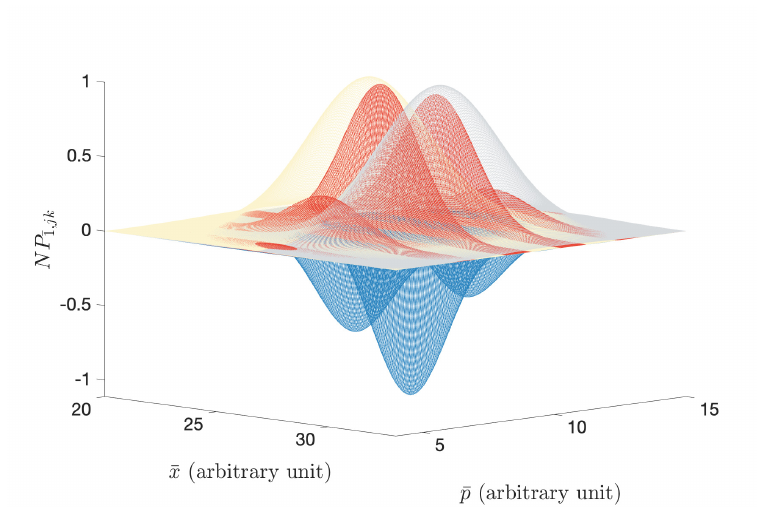
Figure 3 . An illustration of the quasi-probability distribution in eq. (2.20) on layer 1 in the Wigner-PS assuming Gaussian distributed weighting functions scaled by N (as explained in the text, the normalization of the distributions is irrelevant, just the width and shape are). The yellow/grey areas represent P / P , and the red/blue area are for the positive/negative values ¯1 ,jj ¯1 ,kk of P . ¯1 ,jk